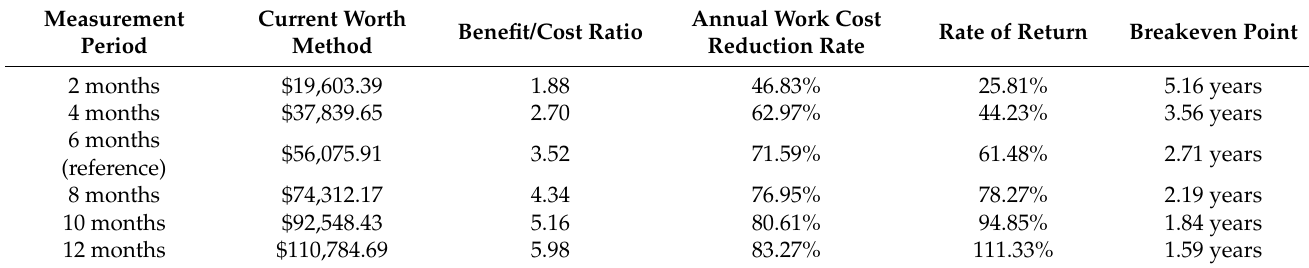
Table A2. Sensitivity analysis results according to the measurement period.